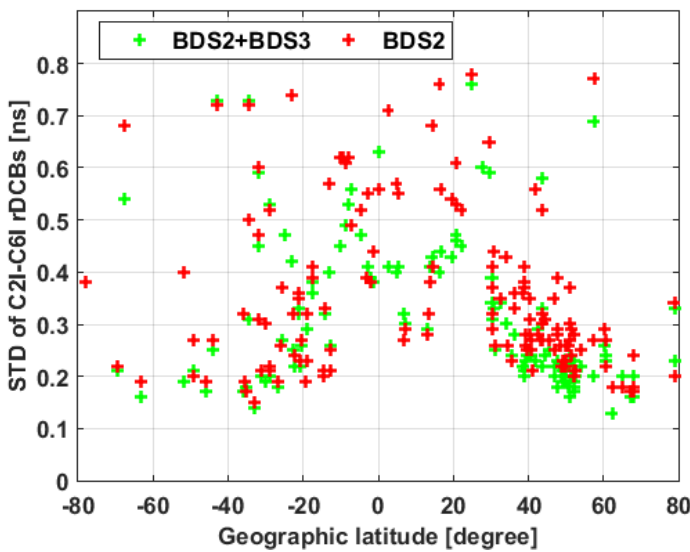
Figure 15. STDs of receiver C2I–C6I DCB estimates at each station. The stations are aligned by geographic latitude on the horizontal axis.